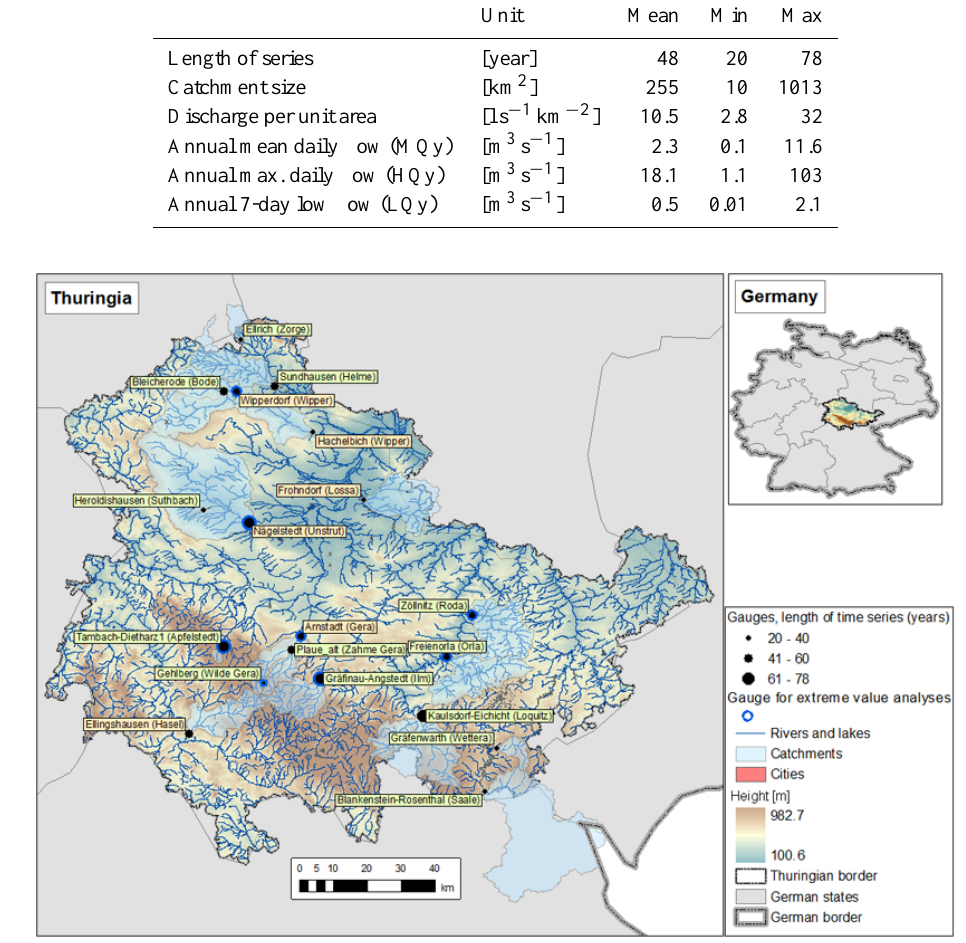
Fig. 1. Federal State Thuringia with selected gauges for trend analyses and extreme value analysis (see text for